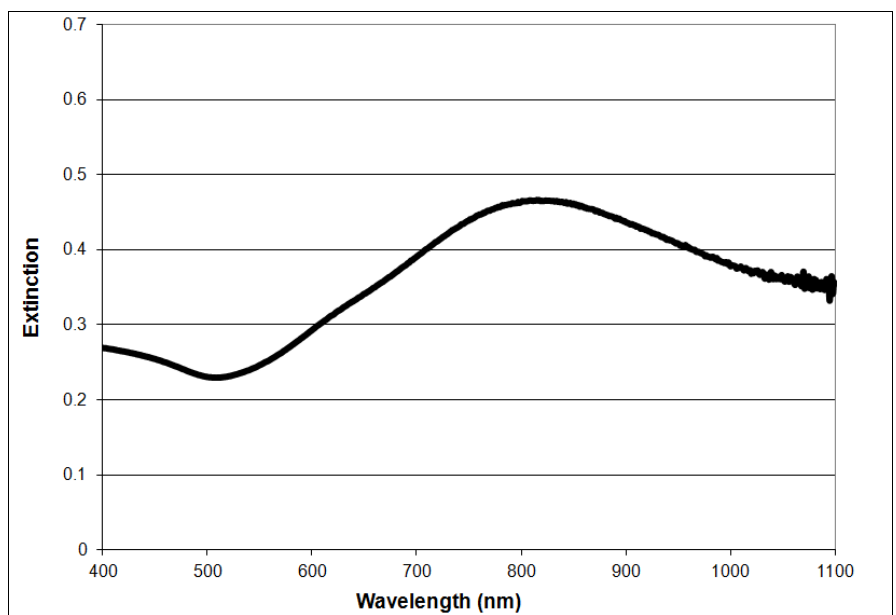
Figure 4. Extinction spectra of Auroshell® particles.